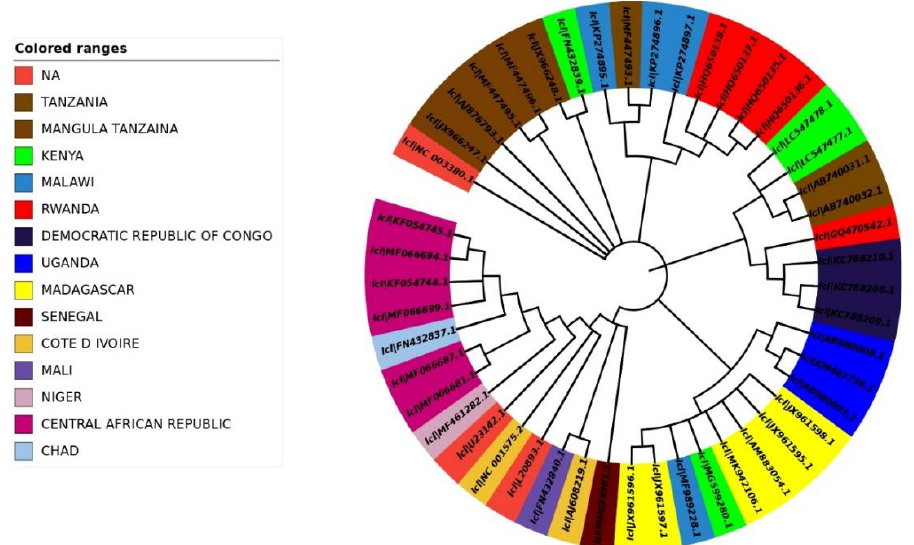
Figure 6. Phylogenetic trees are based on the polyprotein-coding regions of 50 RYMV strains. The tree was generated by the maximum likelihood (ML) method using Clustal X2. The tree was designed by using the online tool “iTOL”.